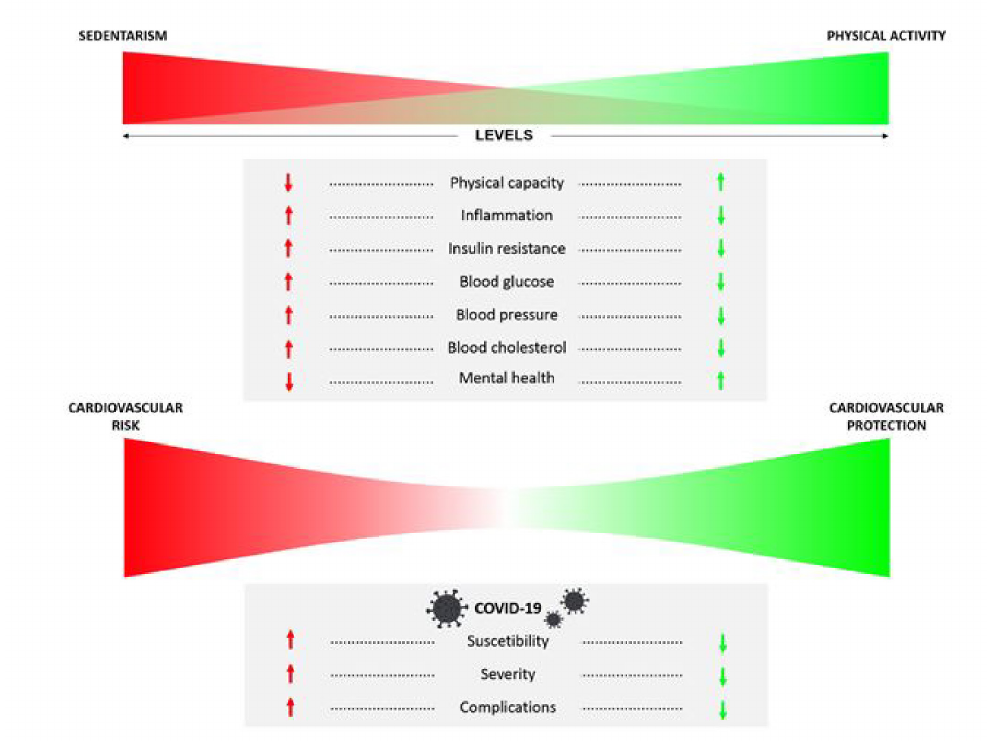
Figure 1 - The potential effects of sedentarism and physical activity during long-term on health parameters, and possible consequences of COVID-19 disease. High levels of sedentarism and low physical activity during long periods can trigger changes in physical, metabolic, cardiovascular and inflammation parameters, resulting in an elevated cardiovascular risk in the future, and predisposing individuals to a higher risk of SARS-CoV-2-associated disease, whereas the reduction in sedentarism and increased physical activity levels can to meliorating these components of health, reducing the cardiovascular risk and potentially improvement the protection against the